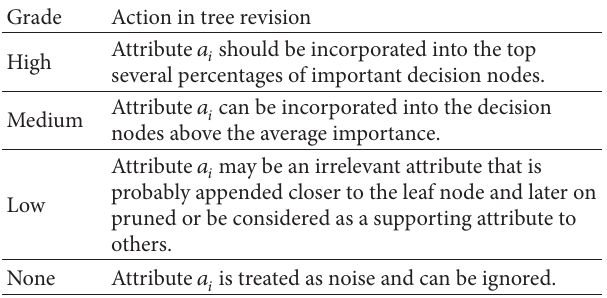
Table 1: Four classes of the importance